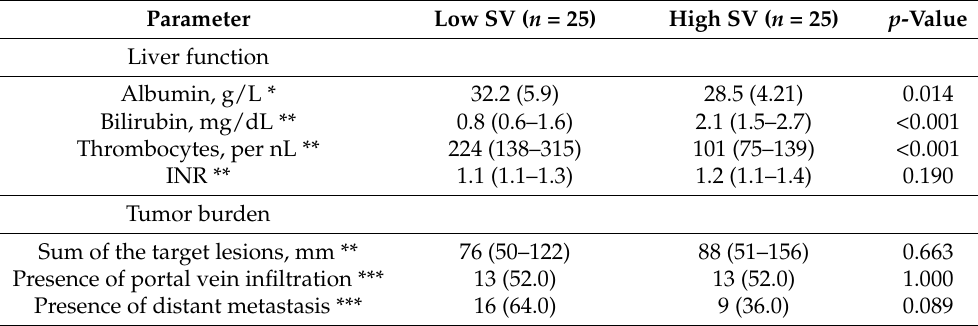
Table 2. Comparison of liver function- and tumor burden-related parameters in patients with low and high splenic volume (SV).